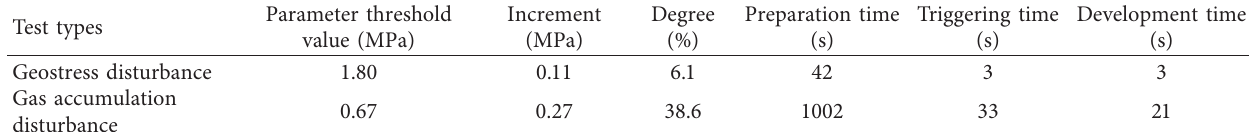
Table 1: Comparison of delay outburst under two disturbance conditions.